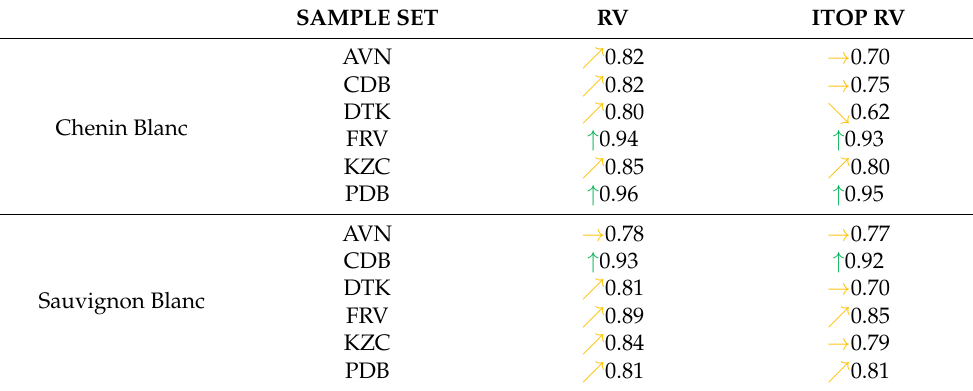
Table 7. Pairwise RV coefficients ( p ≤ 0.01) between PCA and MFA for the mid-level data fusion. SAMPLE